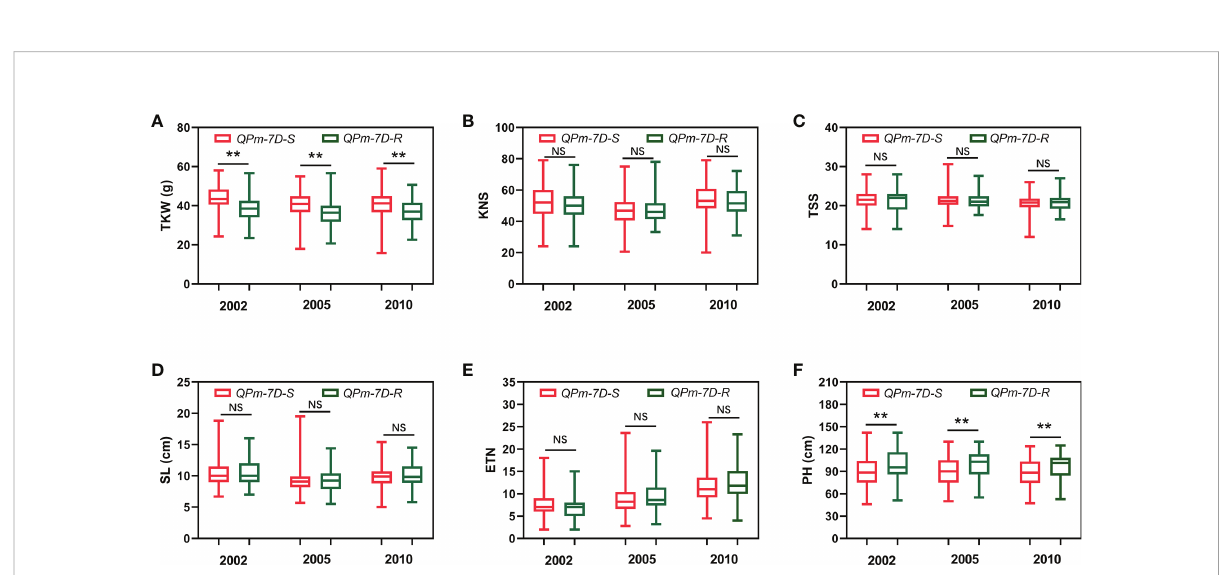
FIGURE 5 Haplotypes analysis with agronomic traits of QPm.cas-7D in the Chinese modern cultivars. Comparison analysis of QPm.cas-7D haplotypes with the TKW (A) , KNS (B) , TSS (C) , SL (D) , ETN (E) , and PH (F) of the Chinese modern cultivars in three environments. ** P < 0.01 and * P < 0.05 (two- tailed t test) indicates a signi fi cant difference to the two haplotypes. NS, no signi fi cant